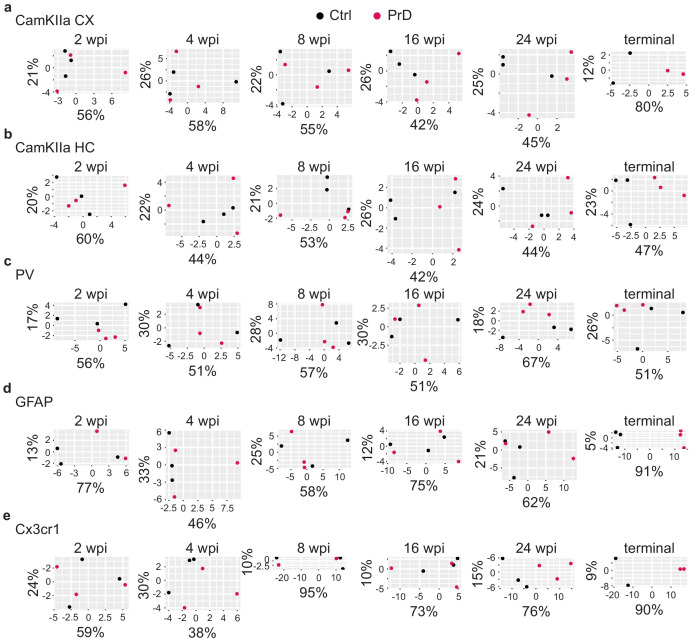
Principal component analysis of control and prion disease samples.Principal component analysis of control (ctrl) and prion disease (PrD) samples at different time points during disease progression. The principal components 1 and 2 are plotted on the x and y axes, respectively. The % of variance explained by these principal components is indicated. Ctrl and PrD samples showed a clear separation only at the terminal stage, most prominently in GFAP and Cx3cr1+ cells.